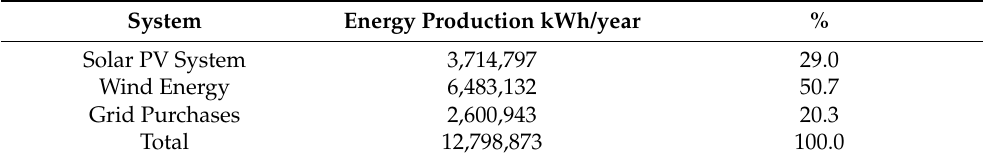
Table 2. Energy production from renewables and grid